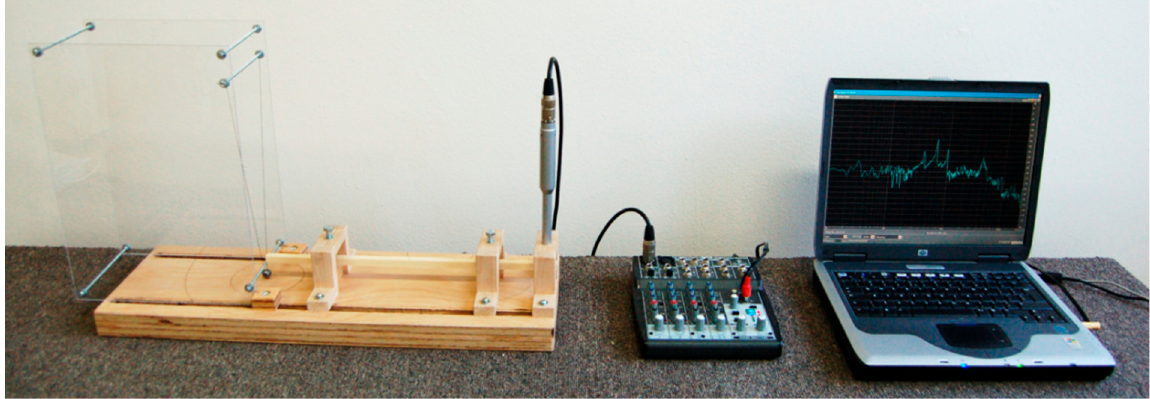
Figure 3. Experimental device for FFT analysis.